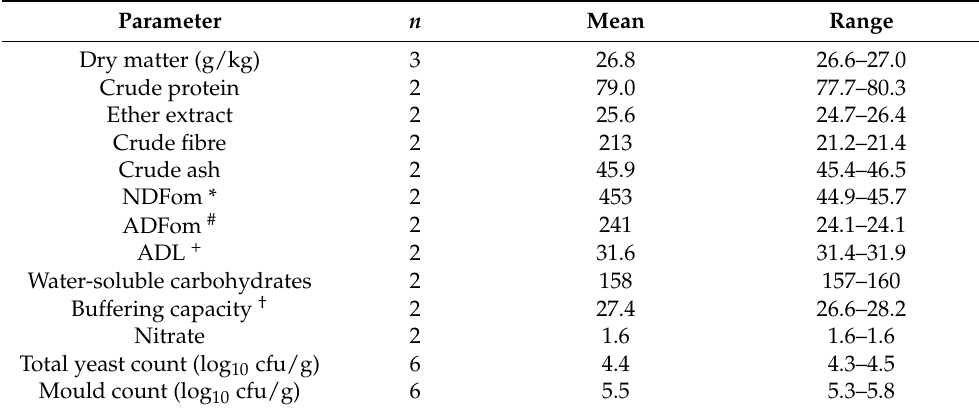
Table 1. Chemical composition and microbial counts of fresh maize before silo filling (means in g/kg DM, unless stated